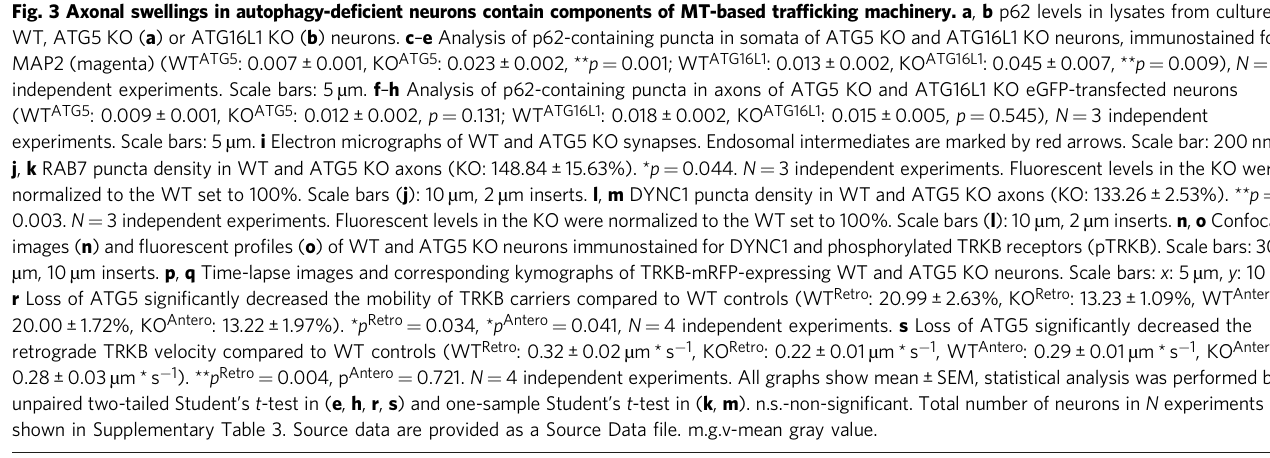
Fig. 3 Axonal swellings in autophagy-de fi cient neurons contain components of MT-based traf fi cking machinery. a , b p62 levels in lysates from cultured WT, ATG5 KO ( a ) or ATG16L1 KO ( b ) neurons. c – e Analysis of p62-containing puncta in somata of ATG5 KO and ATG16L1 KO neurons, immunostained for MAP2 (magenta) (WT ATG5 : 0.007±0.001, KO ATG5 : 0.023±0.002, ** p = 0.001; WT ATG16L1 : 0.013±0.002, KO ATG16L1 : 0.045±0.007, ** p = 0.009), N =